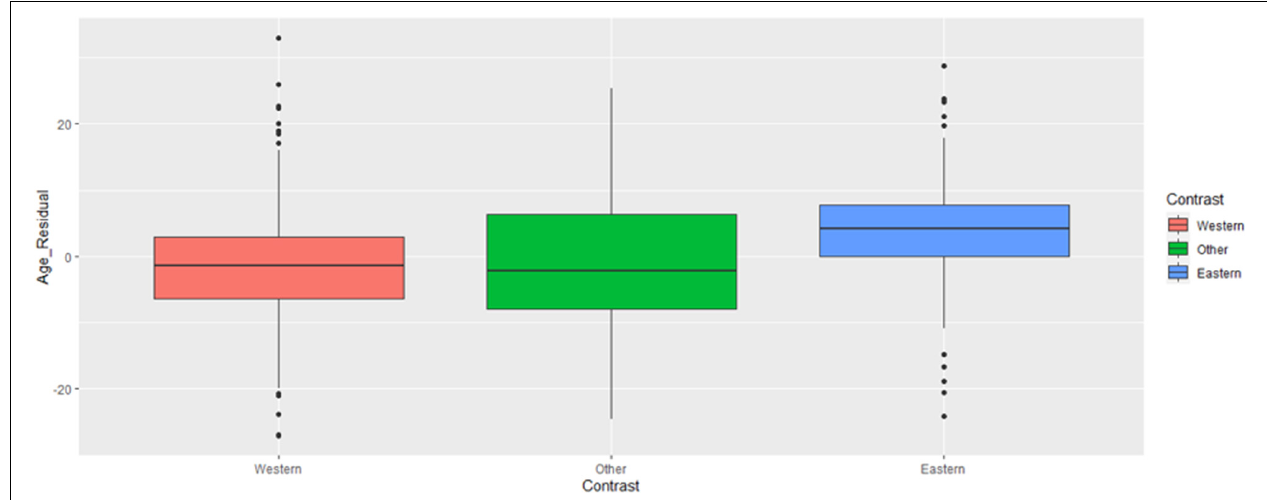
FIGURE 2 | Business leader ages by culture contrast. Age depicted in the figure is adjusted for the presence of the economic and elderly population covariates. See SOM for figures presenting raw (i.e., unadjusted by covariate) age scores.